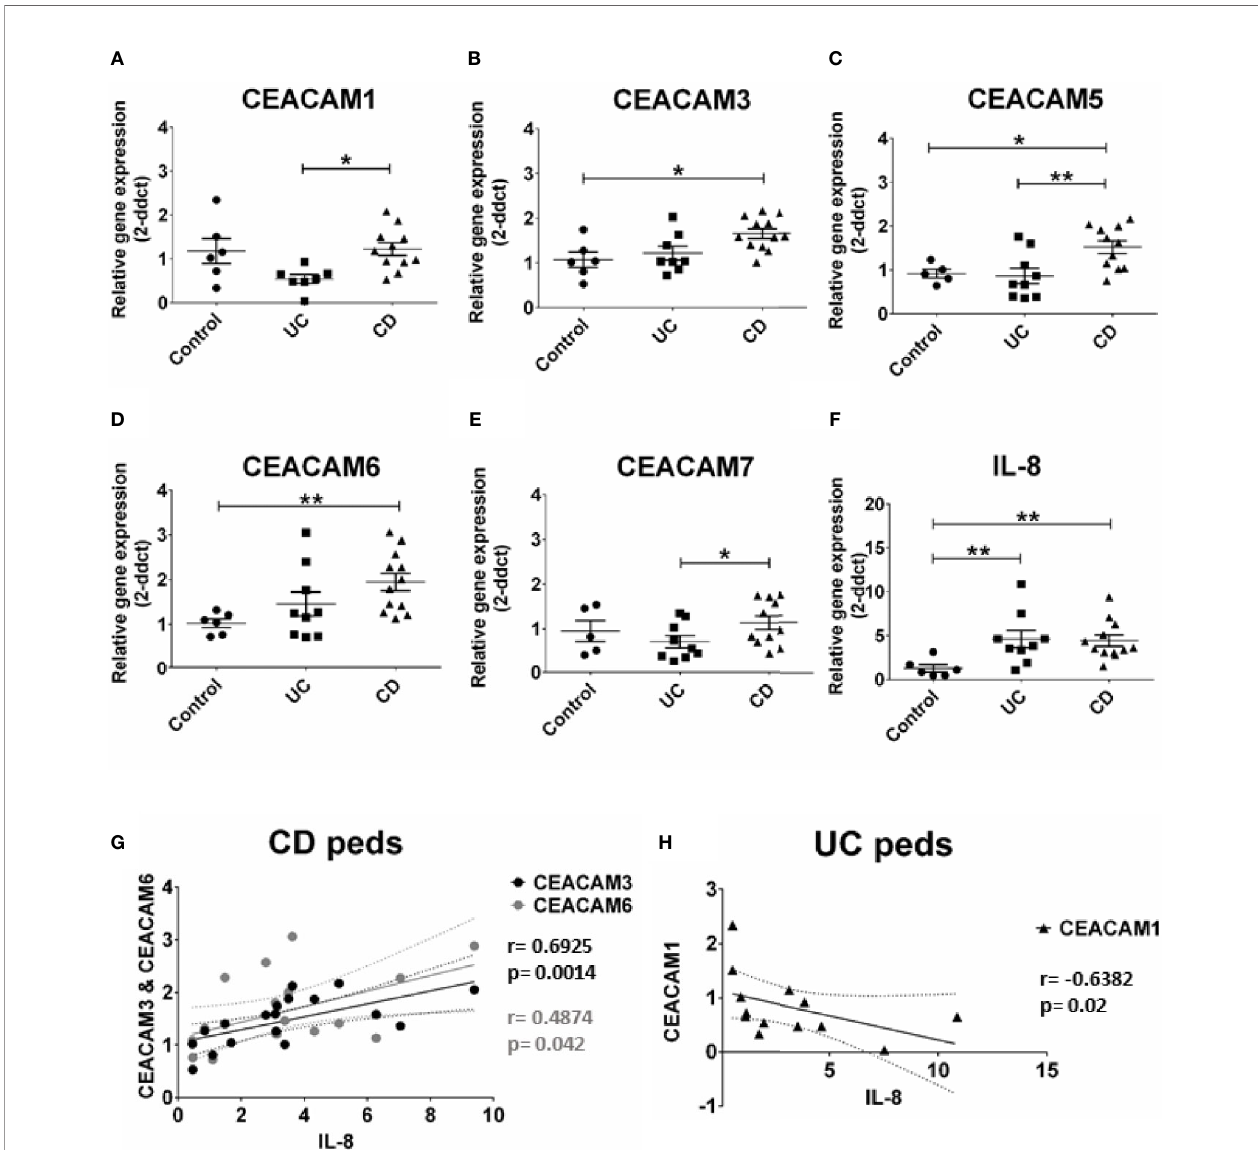
FIGURE 1 | CEACAMs gene expression in pediatric colonic mucosa of patients with Ulcerative colitis (UC) and Crohn ’ s disease (CD) and controls. Gene expression of (A) CEACAM1, (B) CEACAM3, (C) CEACAM5, (D) CEACAM6, (E) CEACAM7, (F) IL-8 as determined by RT-qPCR. (G) Spearman correlation on relative mRNA levels between IL-8 and CEACAM3 and CEACAM6 in pediatric colonic CD samples and of (H) IL-8 and CEACAM1 in pediatric colonic UC. n=9, Ulcerative Colitis (UC); n=12 Crohn ’ s Disease (CD); and n=6 controls. An ANOVA test with post-hoc analysis was used to analyze gene expression data and Spearman correlation test. *P < 0.05, **P <